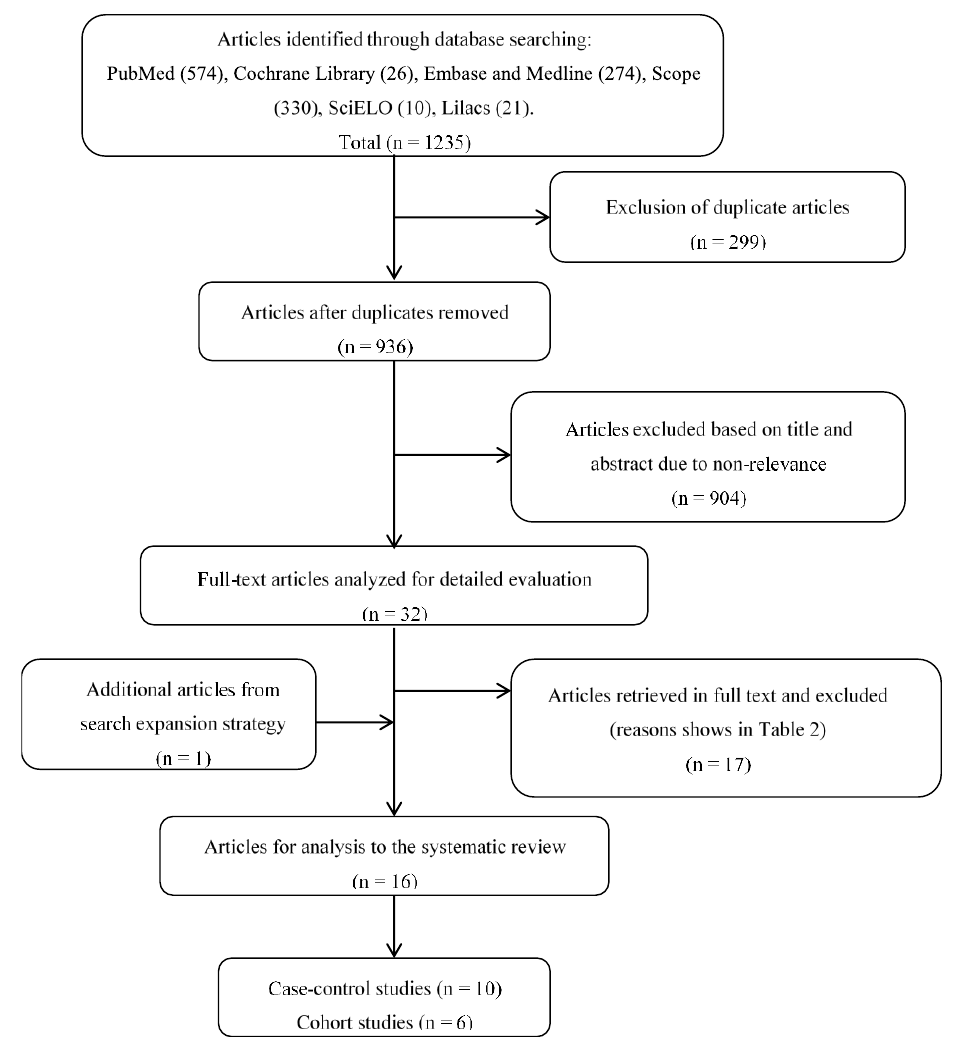
Figure 1. Search method, identification, selection, and inclusion of articles.